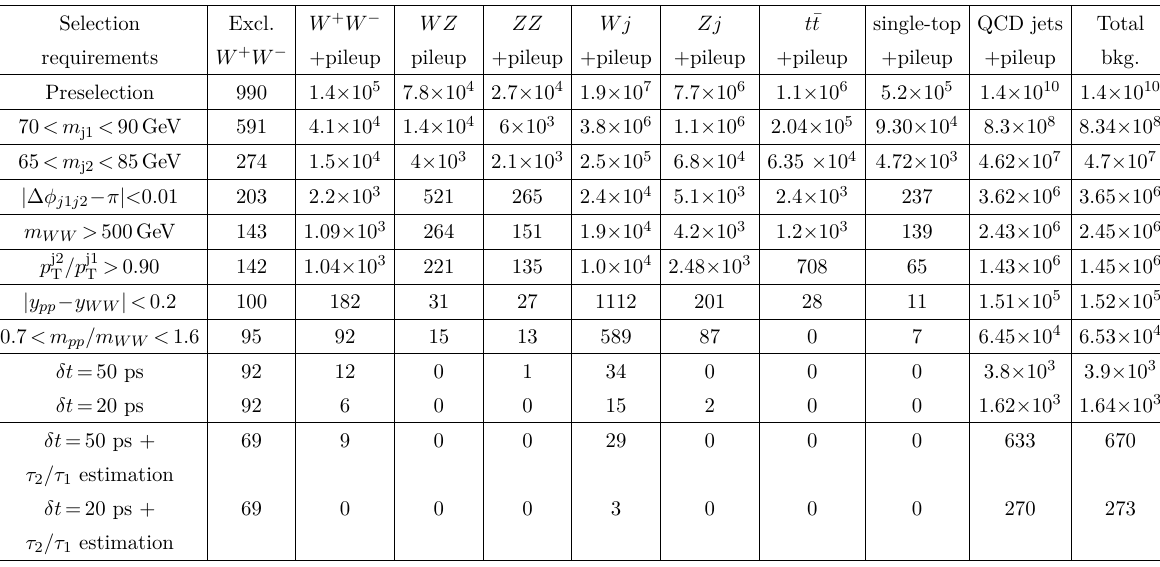
Table 1 . Number of events for 300 fb − 1 at 14 TeV after each selection criterion for W + W − exclusive signal (when both W s decays hadronically into large-radius jets), and non-diffractive W + W − + pileup, W ± Z + pileup, ZZ + pileup, W + jet backgrounds. The preselection requires the presence of two large-radius jets of p T > 100 GeV each, no isolated lepton and at least one proton on each side with 0 . 015 < ξ < 0 . 15 . The four first lines describe the selection on the W bosons sides using the central CMS or ATLAS detector, the two next lines the exclusivity requirements using the proton detectors. Yields estimated for time-of-flight difference with precision values of 50 ps or 20 ps are shown as well. The bottom rows correspond to an estimation based on the N -subjettiness ratio τ 2 /τ 1 cut based on ATLAS and CMS performance results